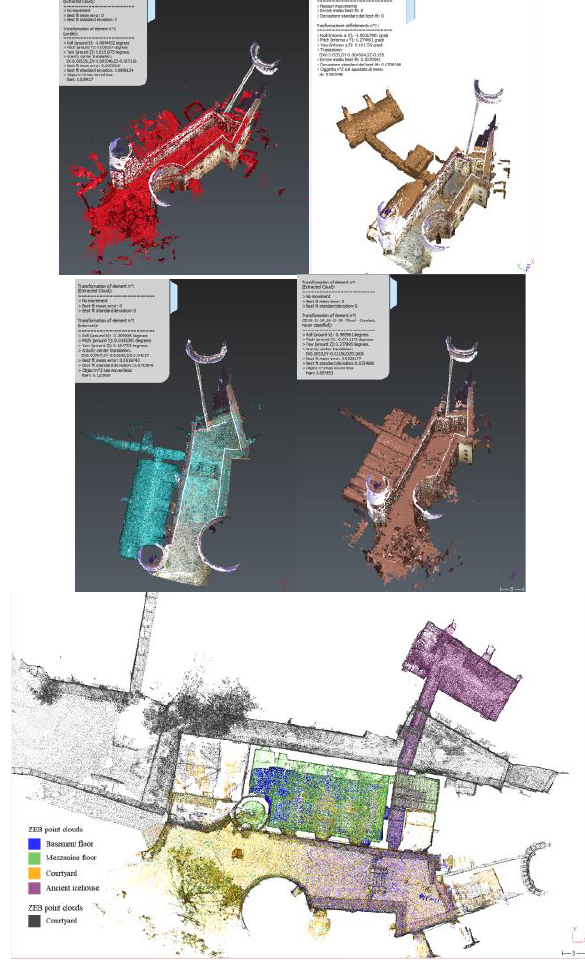
Figure 13. The ZebRevo clouds aligned by a best fit registration.